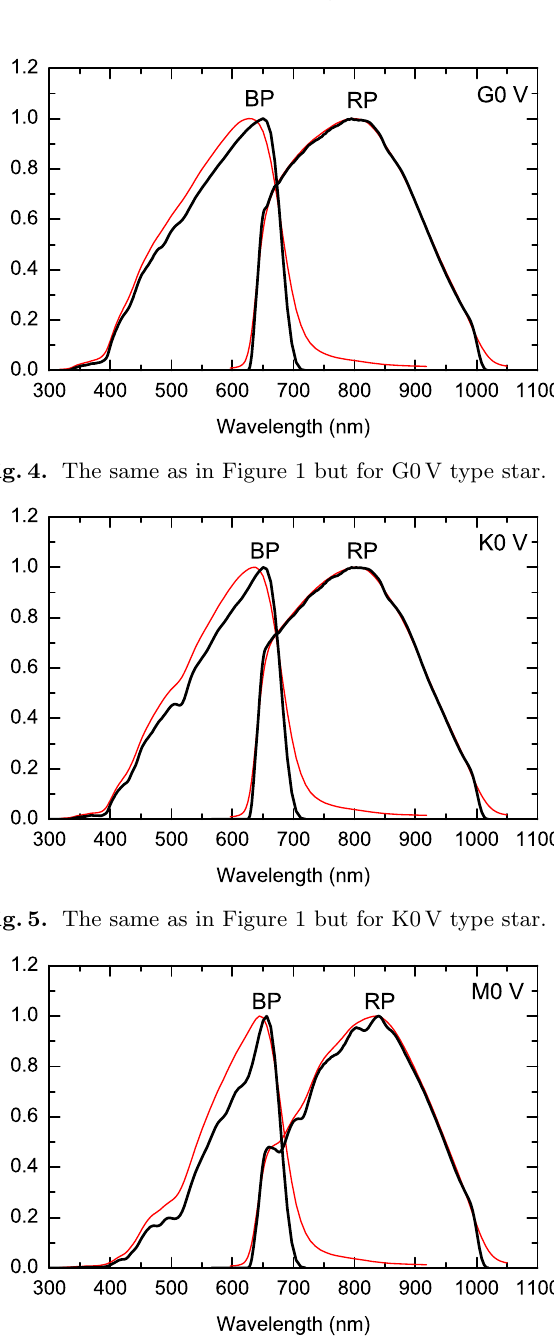
Fig. 6. The same as in Figure 1 but for M0 V type